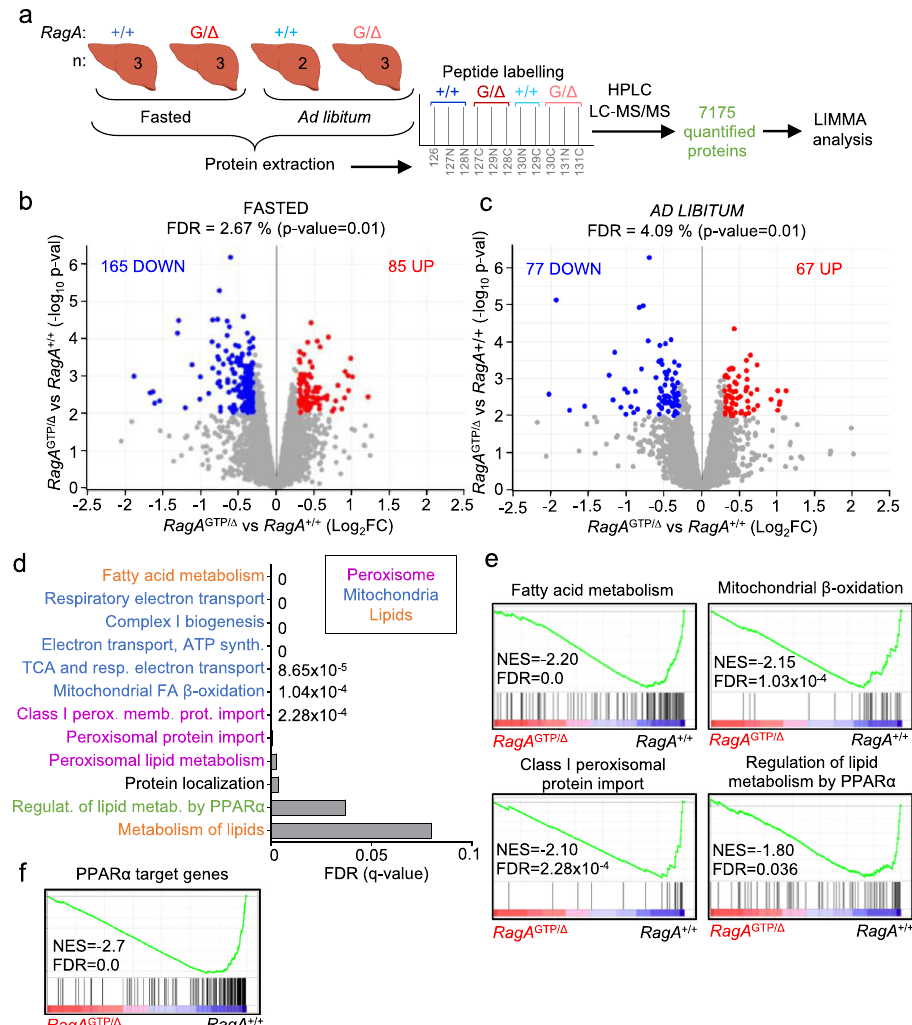
Fig. 4 Proteomic analysis of RagA GTP/ Δ livers revealed blunt PPAR α transcriptional program during fasting. a Schematic summary of the proteomics experimental setting. Protein lysates from livers of 19- to 24-week-old RagA + / + (ad libitum n = 2 and fasted n = 3) and RagA GTP/ Δ (ad libitum n = 3 and fasted n = 3) females were extracted, processed, and labelled as indicated. b Volcano plot highlighting signi fi cantly different protein levels in livers from fasted RagA GTP/ Δ ( n = 3) vs. fasted RagA + / + ( n = 3) mice. c Volcano plot highlighting signi fi cantly different protein levels in livers from ad libitum fed RagA GTP/ Δ ( n = 3), vs. ad libitum fed RagA + / + ( n = 2) mice. Statistical signi fi cance for sections b and c was calculated using the LIMMA program as indicated in Materials and Methods. d Graphical representation of the false discover rates (FDRs) from the indicated Reactome gene sets. e , f Enrichment of gene sets (GSEA) related to indicated Reactome signatures ( e ) or related to our PPAR α targets curated list ( f ) in livers from fasted RagA GTP/ Δ ( n = 3) and RagA + / + ( n = 3) mice. NES: normalized enrichment score; FDR: false discovery rate and error bars depict Standard deviation